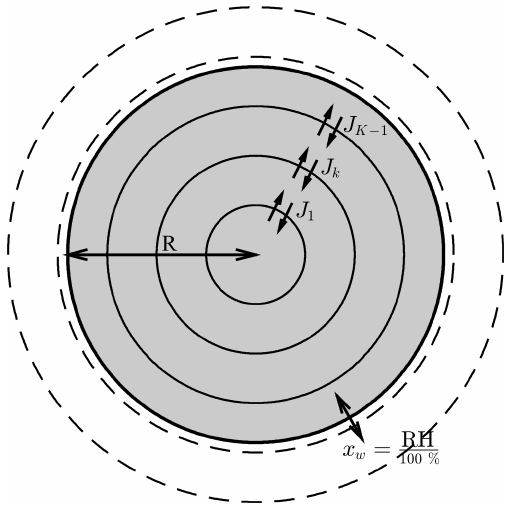
Figure 1. The aerosol shell model, where diffusion equations are solved numerically to find concentration flux across the shell bound- aries. The flux across the outer shell is set to zero, denoted as J K . However, during each time step water is added to the outer shell to equilibrate it with the surrounding relative humidity, such that x w = RH . For the purposes of this study it is assumed that the 100% aerosol outer shell equilibrates instantaneously with the ambient conditions in order to investigate the effect of condensed phase dif- fusion on equilibration timescales. Concentric shells are initialized to be equally spaced – as the aerosol particle grows or shrinks the number of shells in the model increases or decreases. The radius of the outer aerosol shell is variable and acts as a moving boundary to denote the precise size of the